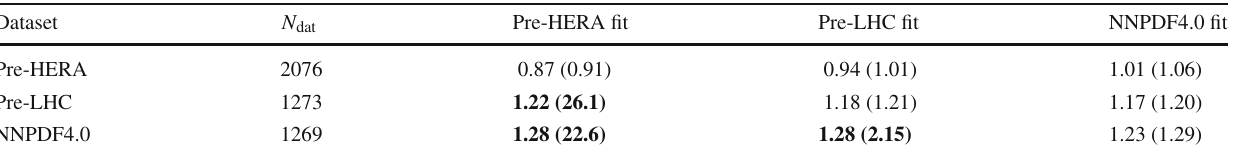
Table 3 Same as Table 2 for the NNPDF4.0 methodology